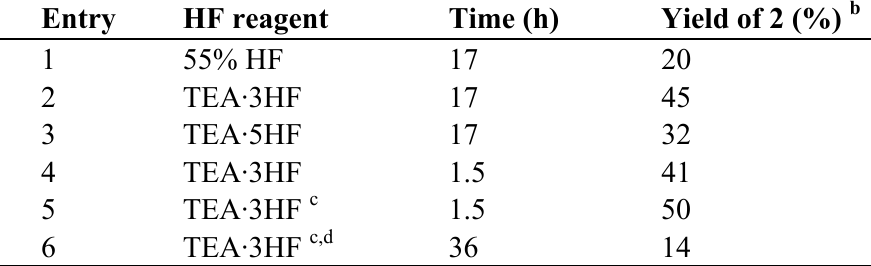
Table 1. Reaction of iodonium ylide 4 with HF reagents a